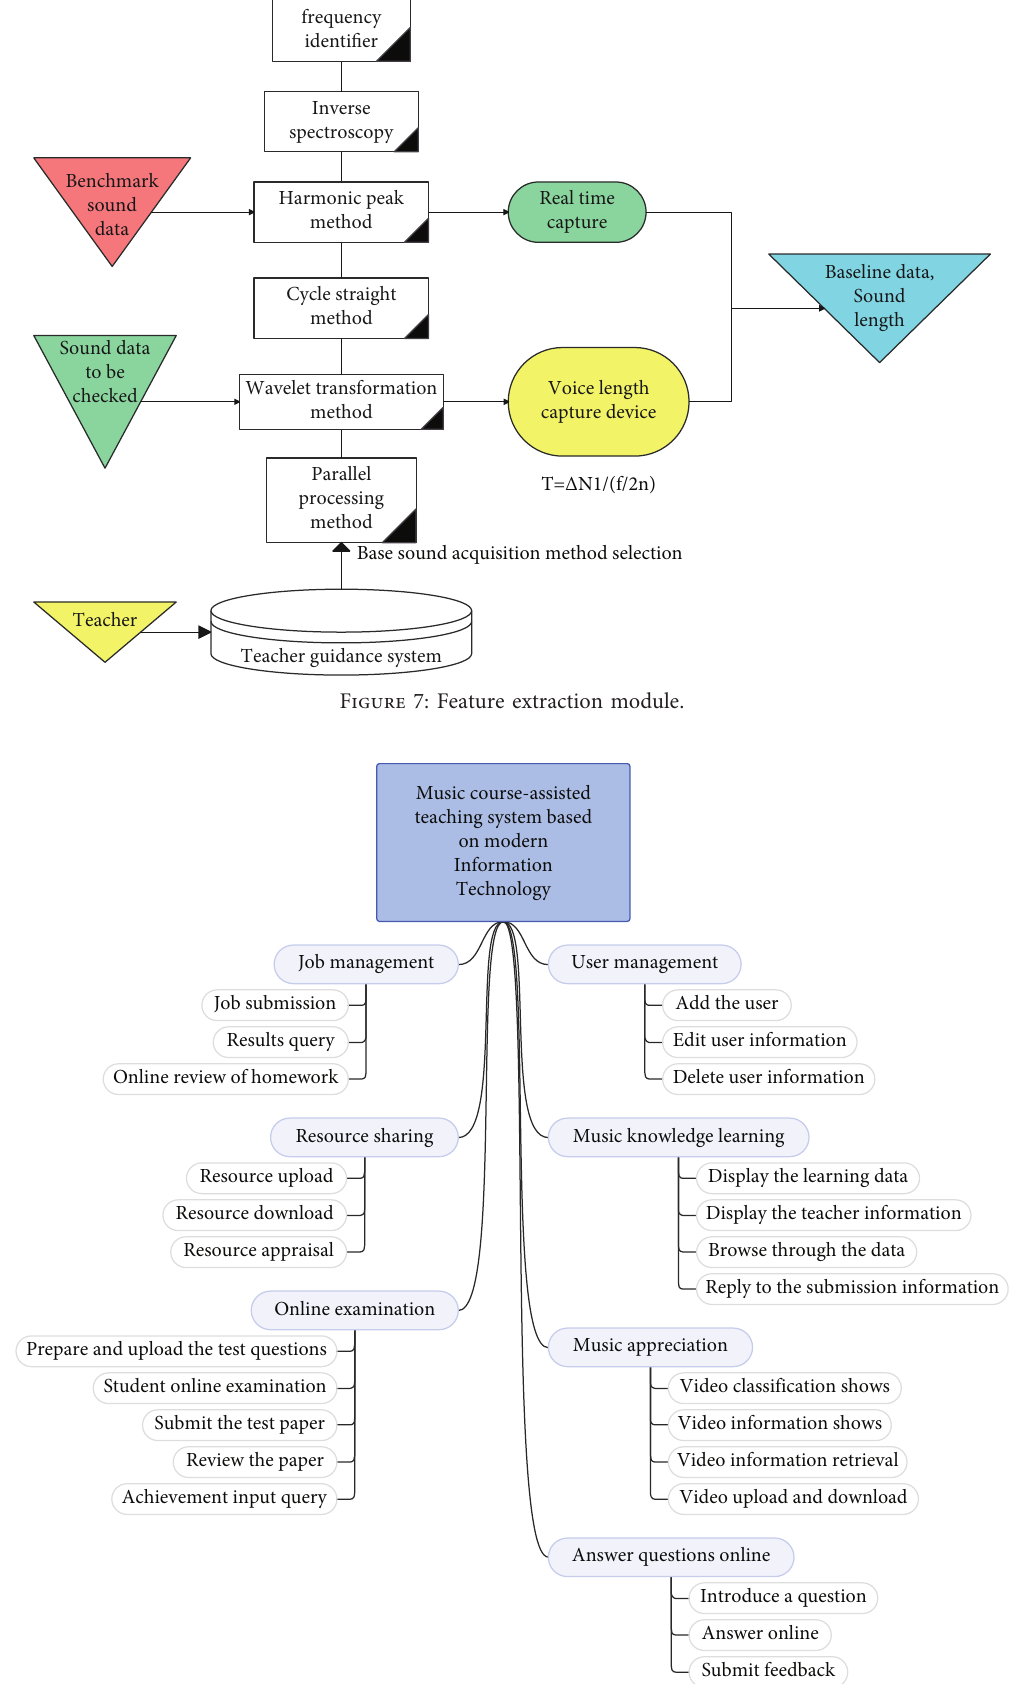
Figure 8: Function module diagram of the music teaching system.